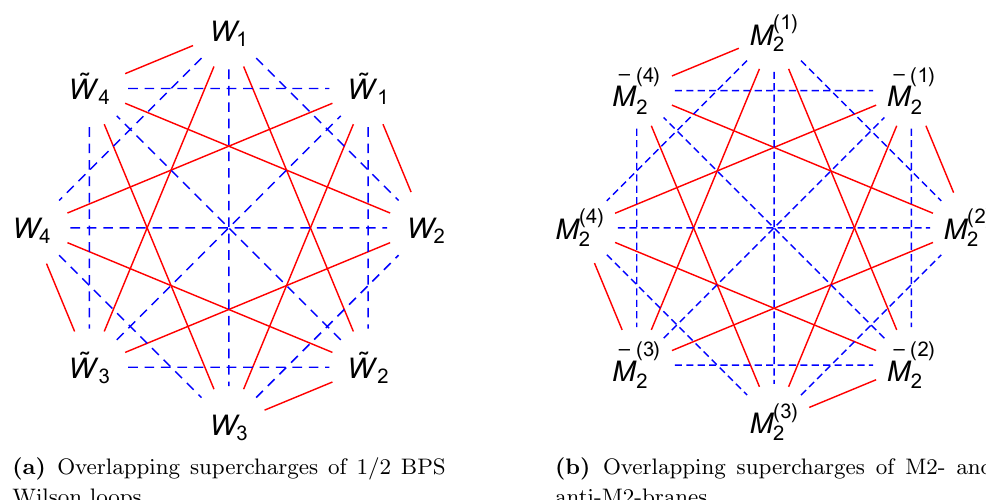
Figure 2. Amount of overlapping supercharges between each pair of 1/2 BPS WLs in ABJM theory and between each pair of M2- and anti-M2-branes in AdS 4 (cid:2) S 7 = Z k . A red solid line means that the two WLs or branes share 2/3 of preserved supercharges. A blue dashed line means that the two WLs or branes share 1/3 of preserved supercharges. Two WLs or branes that are not directly connected by any line have no common preserved